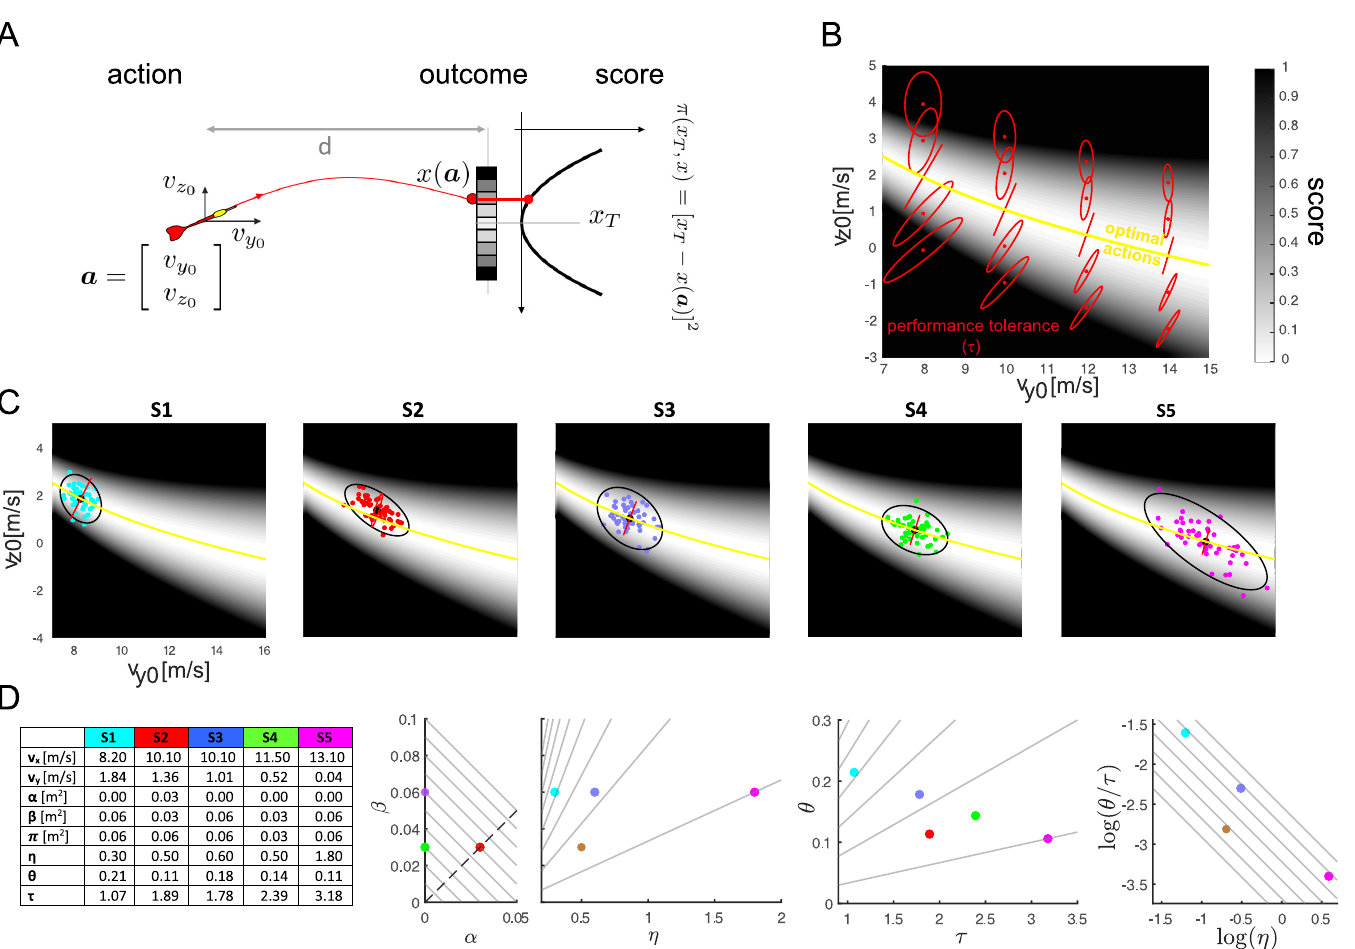
Fig 3. Examples of different throwing strategies in a simulated 2D throwing task. (A) Toy model of a throwing task in which the action ( a ) is characterized by only two parameters, i.e. the horizontal ( v y 0 ) and the vertical ( v z 0 ) release velocity components, the outcome ( x ) is the arrival position of the projectile on a vertical plane at a distance d from the release position, and the score ( π ) is the squared distance of the arrival position from a target ( x ). (B) Action score (gray-shaded background), T solution manifold (yellow line), and Hessian (red ellipses) in a region of release parameters. The score sensitivity for different throwing strategies is captured by the Hessian, which is represented with red ellipses whose major axis indicates, locally, the direction of maximum sensitivity (smaller tolerance to noise). (C) Five (simulated) individual strategies. For each strategy ( S 1- S 5, different panels and colors ) the individual throwing actions are shown together with mean ( large black circle ), their covariance ( black ellipse , 95% C.L.) and the Hessian at the mean action ( red ellipse ). (D) Hessian-based decomposition of the mean score of the five strategies. For each and v ), the mean score ( � p ), and the indicators from the decomposition (score of the mean action α , tolerance-variability index strategy, the mean release parameters ( v y 0 z 0 β , tolerance ( τ ), noise η , and alignment θ ) are presented in the table. The four scatter plots illustrate how these indicators allow to differentiate strategies with different performance as well as strategies with same performance. See text for more